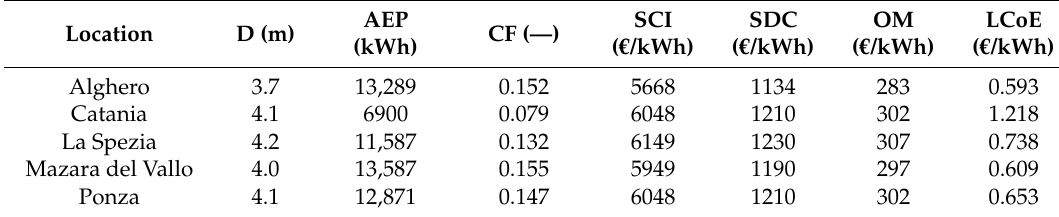
Figure 4. LCoE distribution versus the diameter of the buoy without the fully submerged mass. Table 6. Main data of WEC devices without the fully submerged